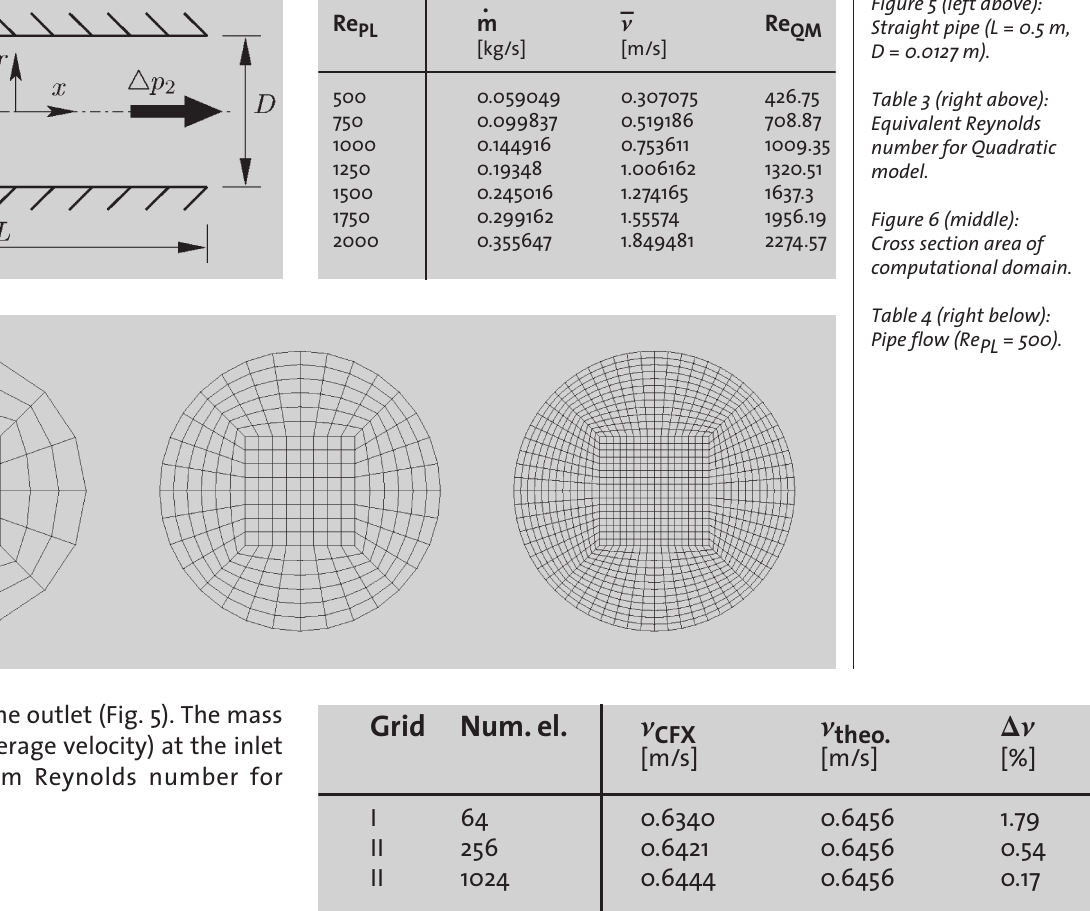
Figure 5 (left above): Straight pipe (L = 0.5 m, D = 0.0127 m). Table 3 (right above): Equivalent Reynolds number for Quadratic model. Figure 6 (middle): Cross section area of computational domain. Table 4 (right below): Pipe flow (RePL = 500).